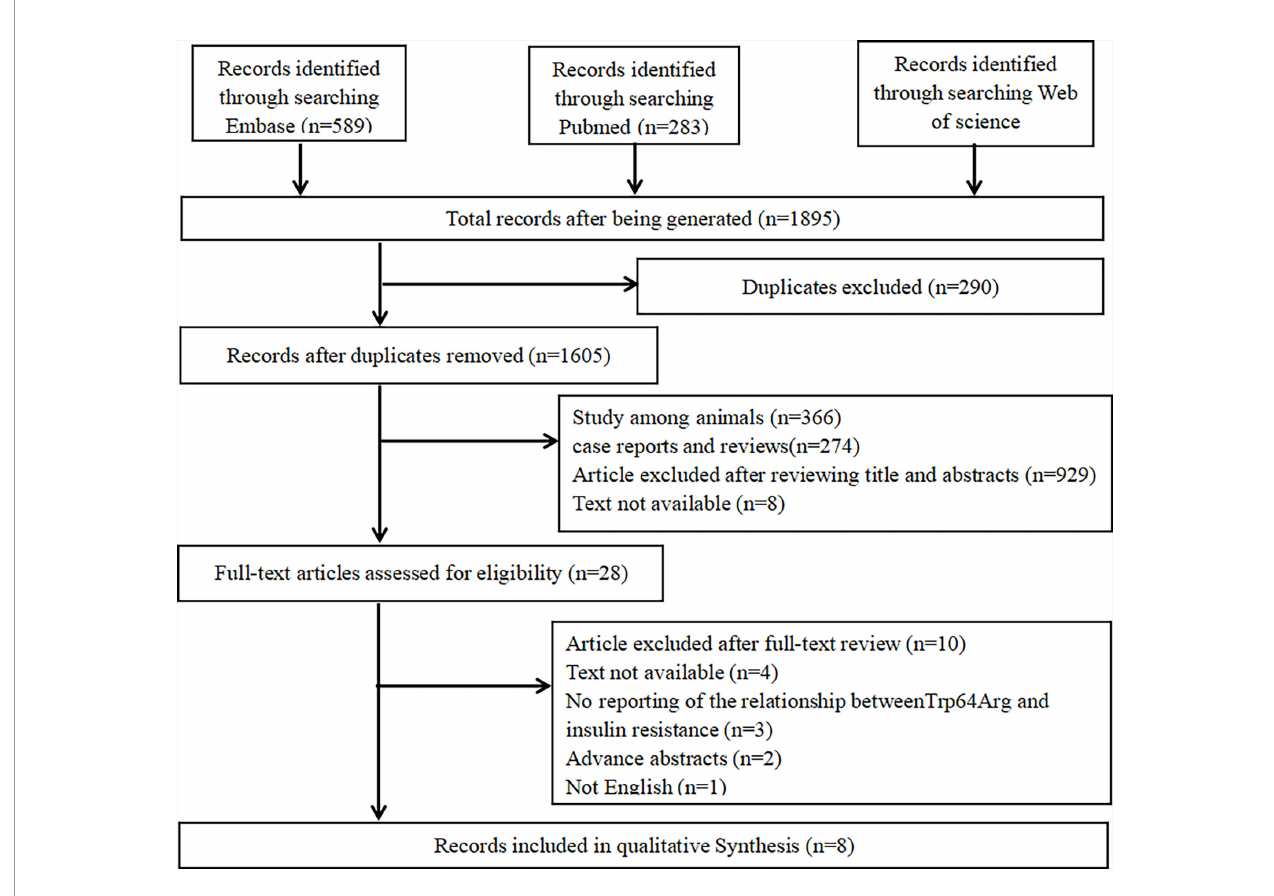
FIGURE 1 | Flow chart of the included